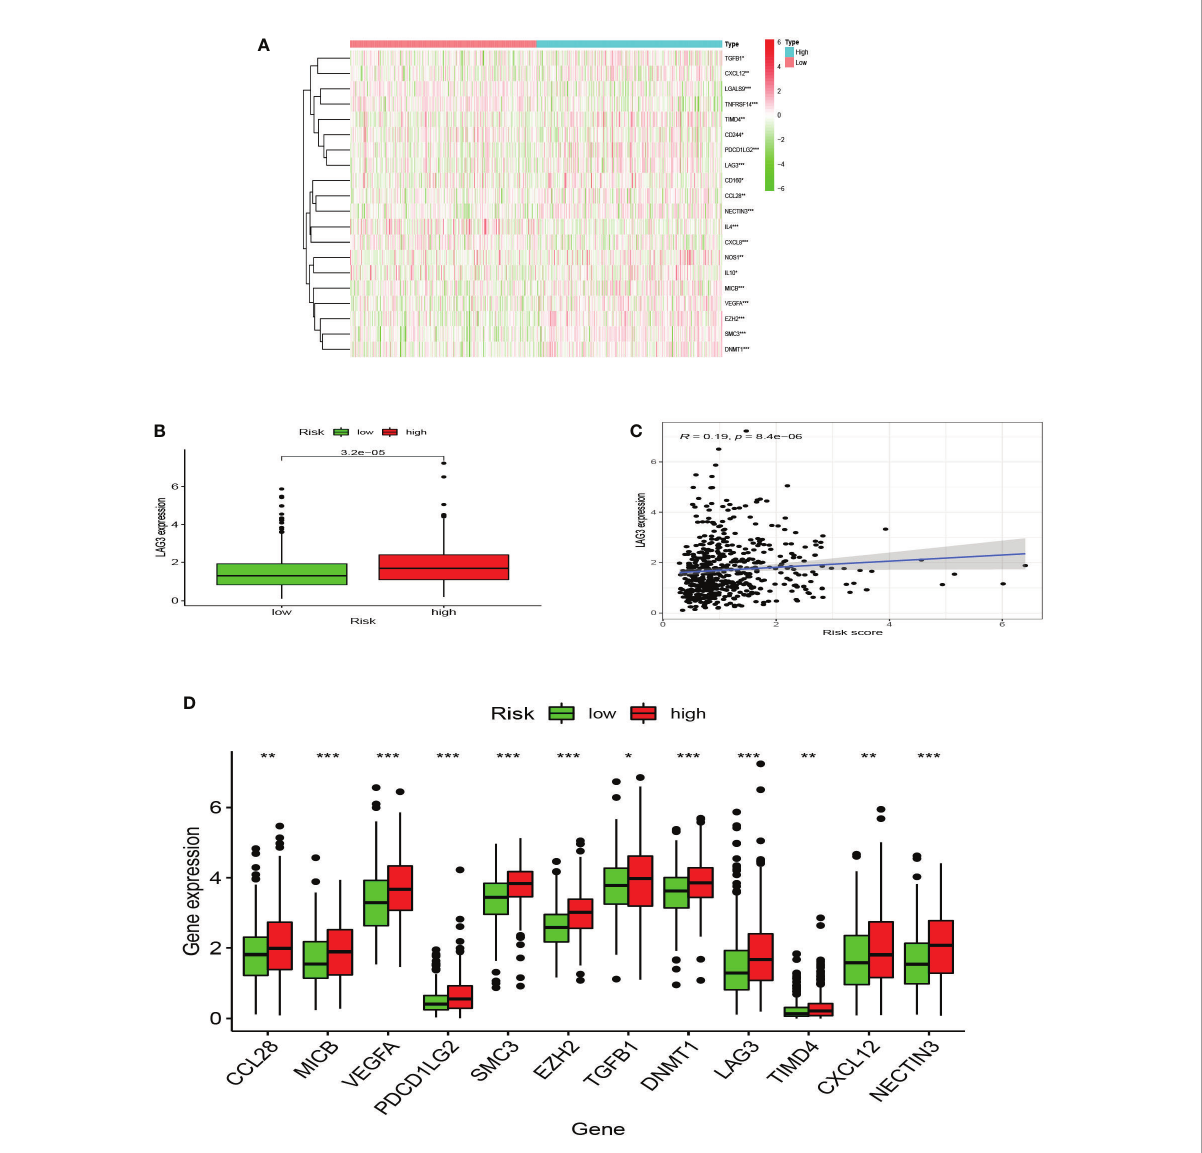
FIGURE 8 A microenvironment with a high risk of hypoxia tends to be immunosuppressive. (A) The heatmap displays the expression of the gene set involved in the negative regulation of anti-tumor immunotherapy in the low and high hypoxia risk groups. (B) The expression levels of LAG3 in high and low hypoxia risk groups. (C) Correlation between the expression of LAG3 and hypoxia risk score. (D) The expression of tumor immunosuppressive genes in the low and high hypoxia risk groups. (*P < 0.05, **P < 0.01 and ***P <